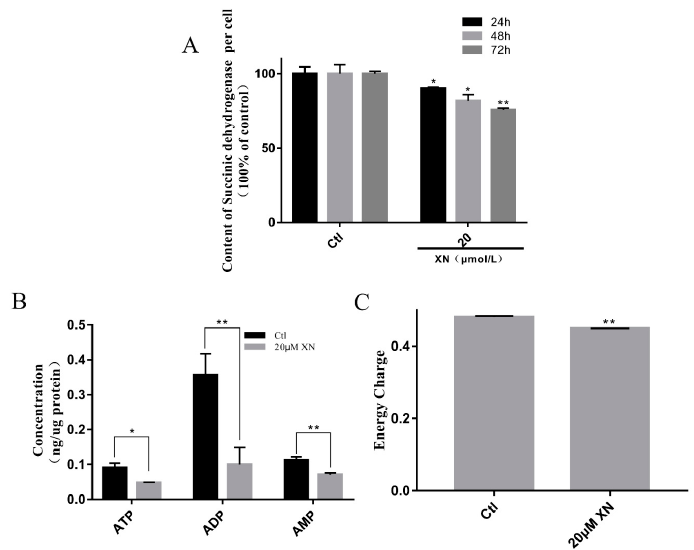
Figure 5. Effect of XN on energy metabolism of C6 cells. ( A ) MTT assay was used to assay the effects of XN treatment on C6 cells within different times. ( B , C ) XN (20uM) reduced the ATP content and energy charge. Cells were treated with XN (20uM) for 24 h, then the content of ATP, ADP, and AMP were determined by HPLC. All data presented are the mean ± SEM from three independent experiments. * p < 0.05, ** p < 0.01 vs. control groups.